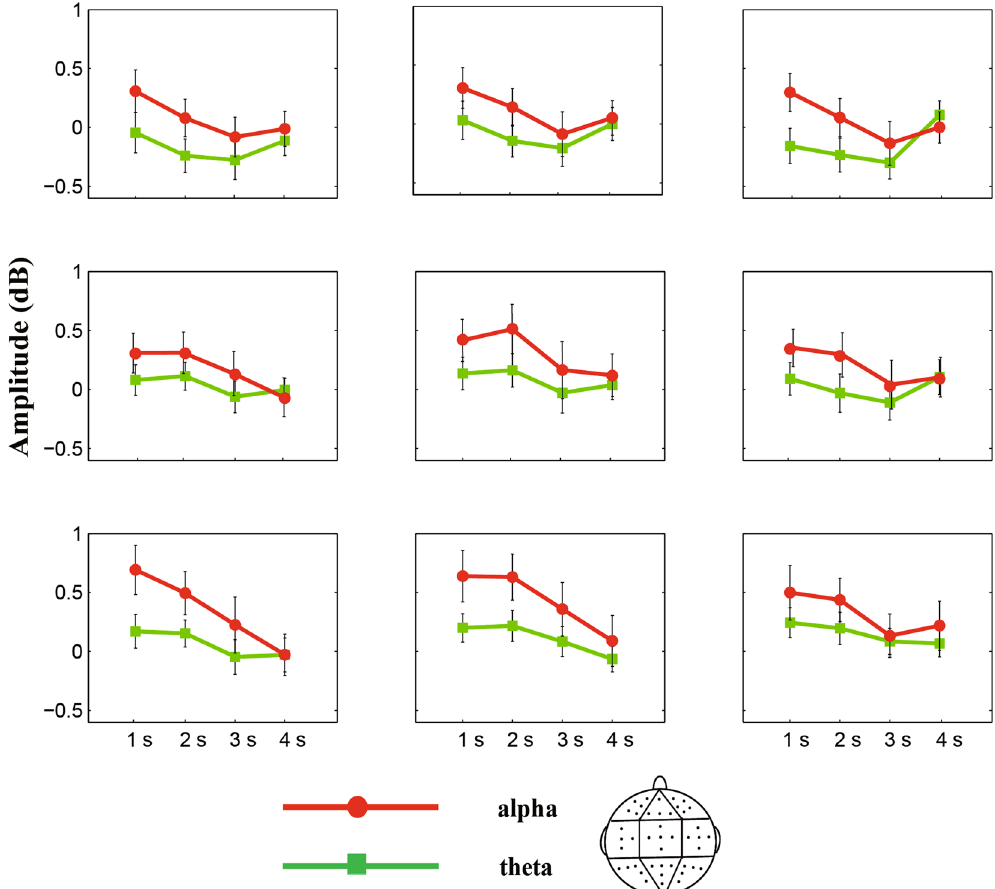
Figure 4. Grand average theta and alpha band powers during auditory duration maintenance in WM in the 1-s, 2-s, 3-s, and 4-s conditions. Grand average theta and alpha band powers during the delay phase are computed for each duration condition, and they are separately plotted for each of the nine analysed electrode clusters. Red and green lines denote the alpha and theta band powers in each duration condition, respectively. Error bars represent the standard error of the mean across